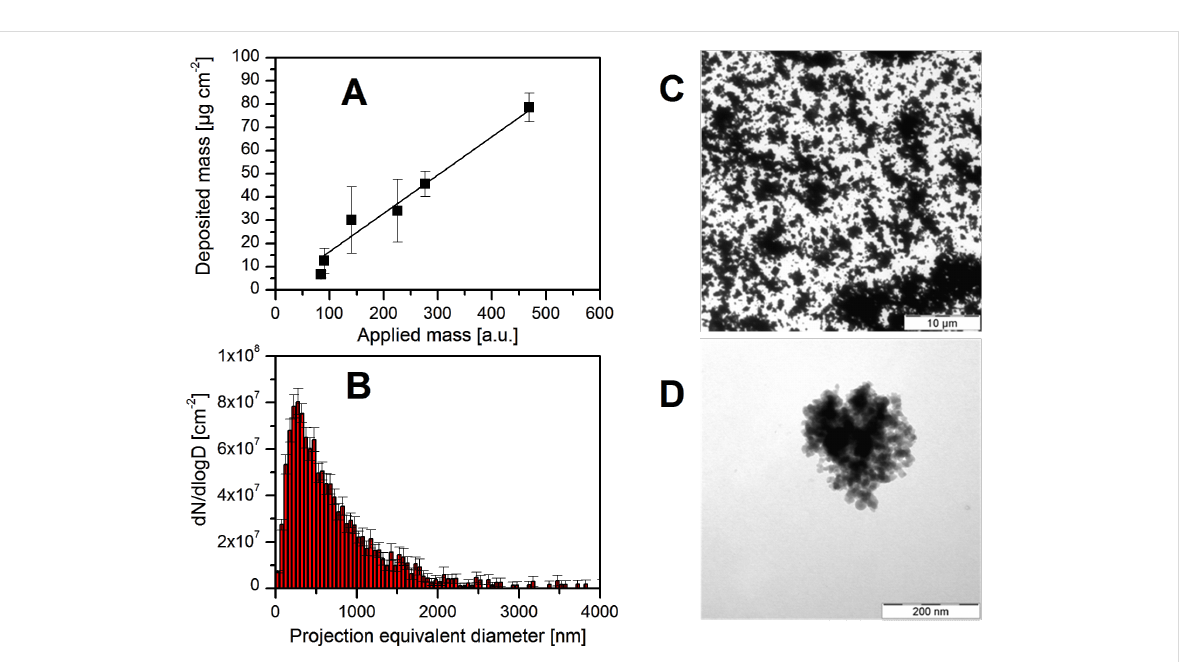
Figure 6: Deposited mass (derived from the number of particles) of Aerosil200 agglomerates as a function of the applied mass (A), size distribution of the corresponding particles (B), as well as the particle loading on a TEM grid after five hours of exposure corresponding to a mass dose of (52 ± 26) µg·cm − 2 (C), and a representative cluster indicating the agglomerate shape (D). Please note that the applied mass in (A) is given in arbi- trary units (third power of the mobility equivalent diameter) and neither the effective density nor the total particle size range was considered. Hence the slope of the linear fit is not equal to the mean mass deposition